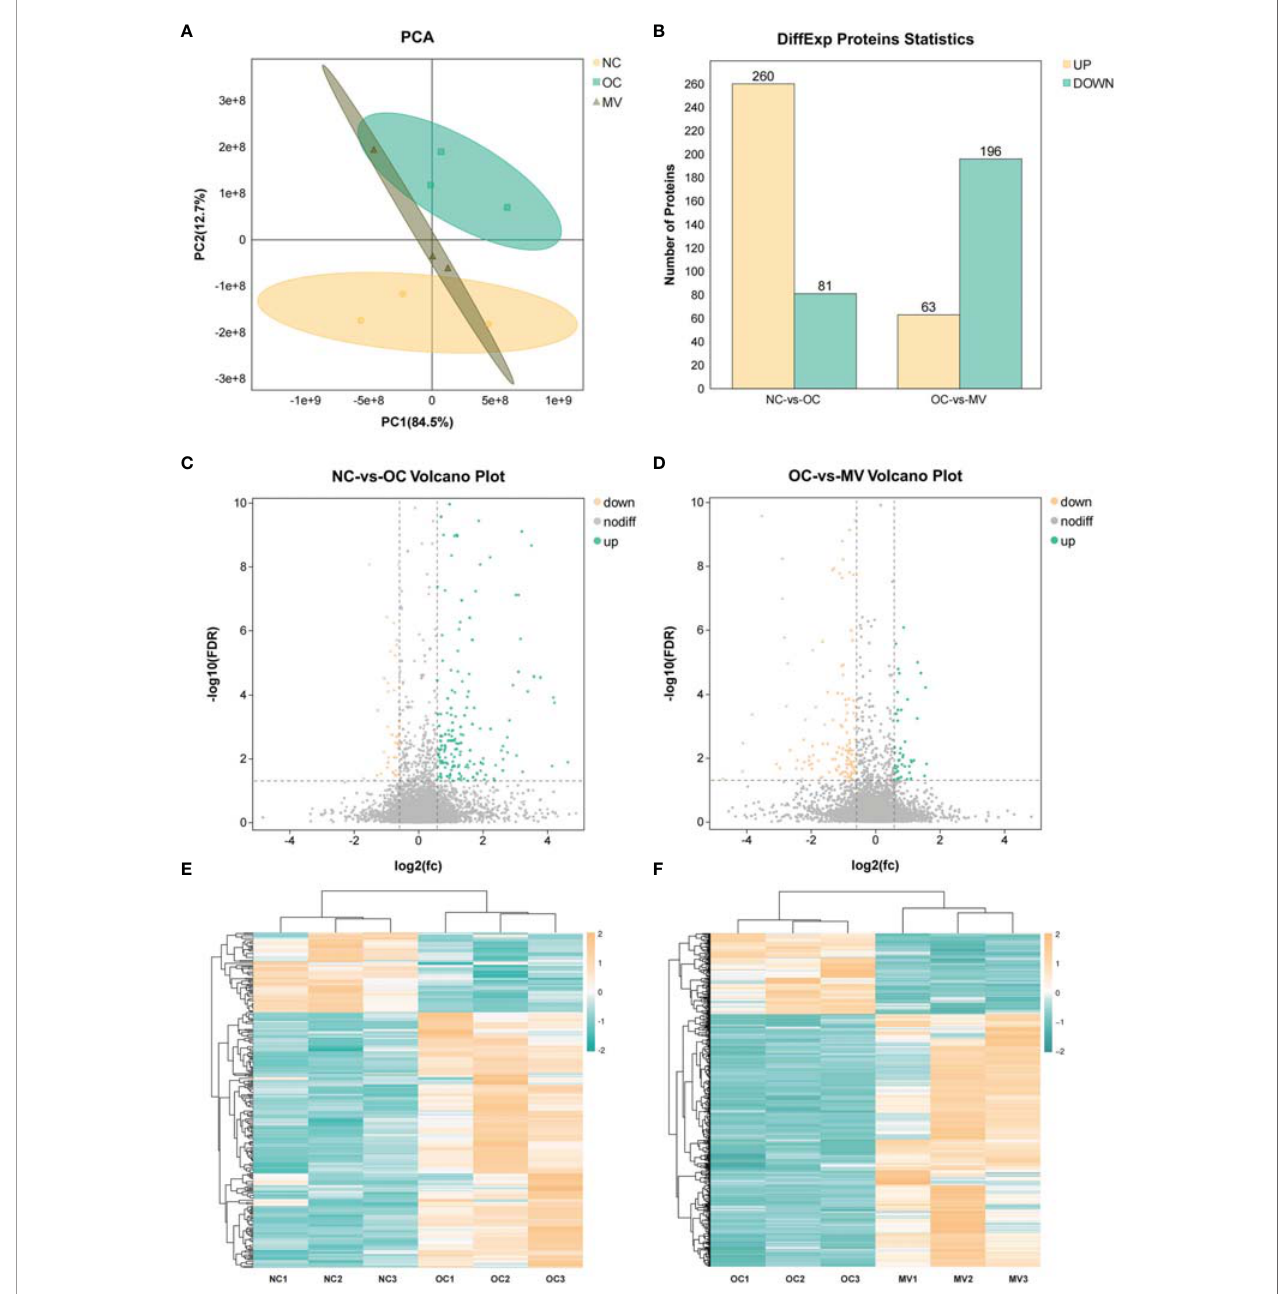
FIGURE 4 | Differential analysis in protein expression levels between the normal control group (NC) or the group treated with 50 mg/kg mogroside V (MV) and the lungs of the ovalbumin control group (OC). (A) Principal component analysis of proteomic data in NC, OC, and MV, including all three groups. These dots represent biological replication. (B) Histogram of differential protein expression between different groups. (C, D) . The volcano map shows the relative abundance of proteins. No statistically signi fi cant differences were observed in the proteins represented by the gray dots. The red dots represent downregulated proteins, and the green dots represent upregulated proteins, which are statistically signi fi cant. (E, F) Heat map of protein expression among the different